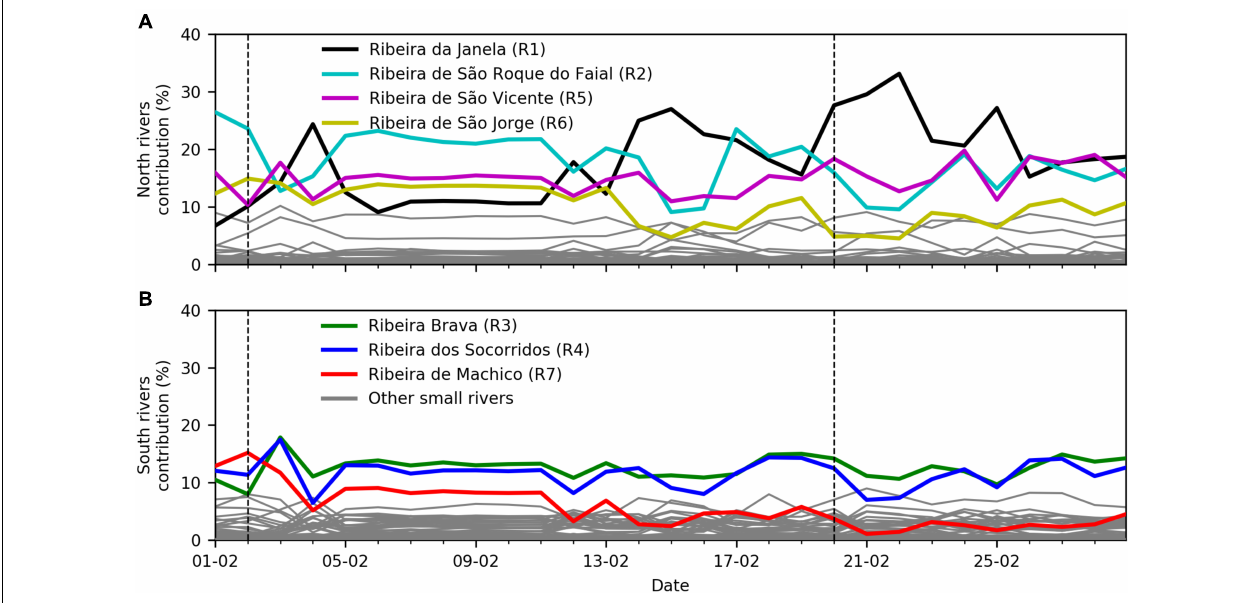
FIGURE 9 | Daily contribution of each river (%) to (A) the northern river discharges, and (B) the southern river discharges during February 2010. The main seven rivers are identified by different colors, while the remaining small rivers are identified by gray. The black dashed lines identify the days of the flash floods events (2nd and 20th of February